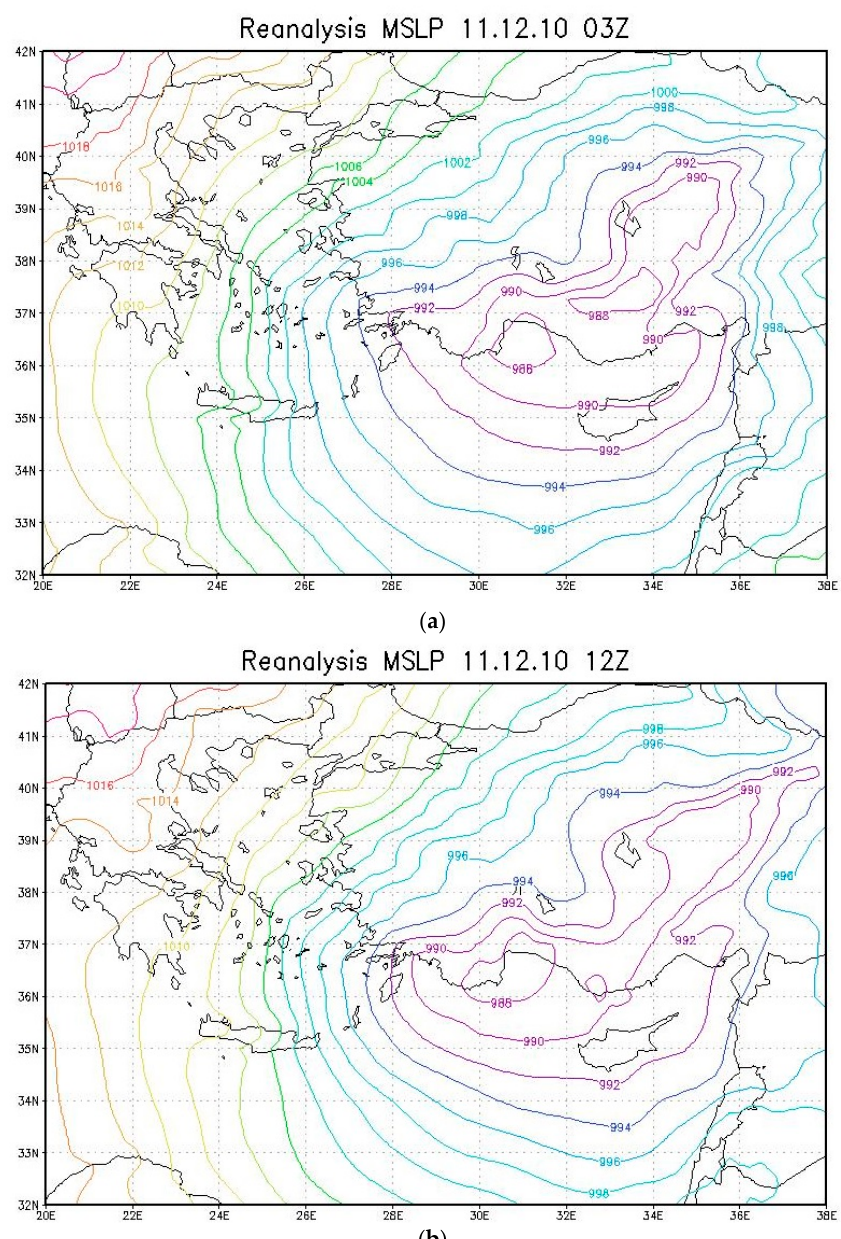
Figure 7. MSLP at ( a ) 11 December 2010 03 UTC (minimum MSLP over Turkey) and ( b ) 11 December 2010 12 UTC (minimum MSLP over the Gulf of Antalya, secondary cyclone) from ERA 5 [20]. The 12 h accumulated rainfall during the explosive cyclogenesis phase is shown in Figure 8. The region of maximum rainfall appears in the northeast corner of the eastern Mediterranean, along the coast of Turkey to the north of Cyprus with a band extending southward along the eastern coast of the Mediterranean and a hint of some bands extend- ing across the sea to the southwest. The 10 m winds at the time of the minimum MSLP of the secondary low, on 11 December 2010 12 UTC, are shown in Figure 9. Maximum sus- tained winds of 20–22 m s − 1 occurred over the eastern Aegean Sea. The winds across the central Levantine basin with speeds over 18 m s − 1 were responsible for the extremely high waves along the eastern coast of the basin.